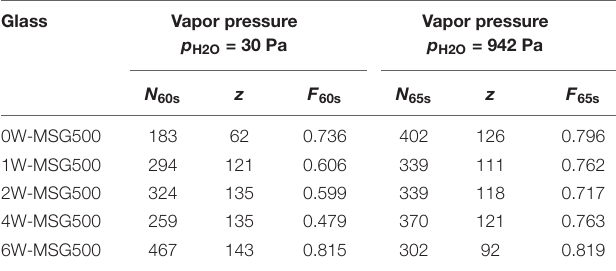
(labmaster130, MBraun, Garching, Germany) providing a